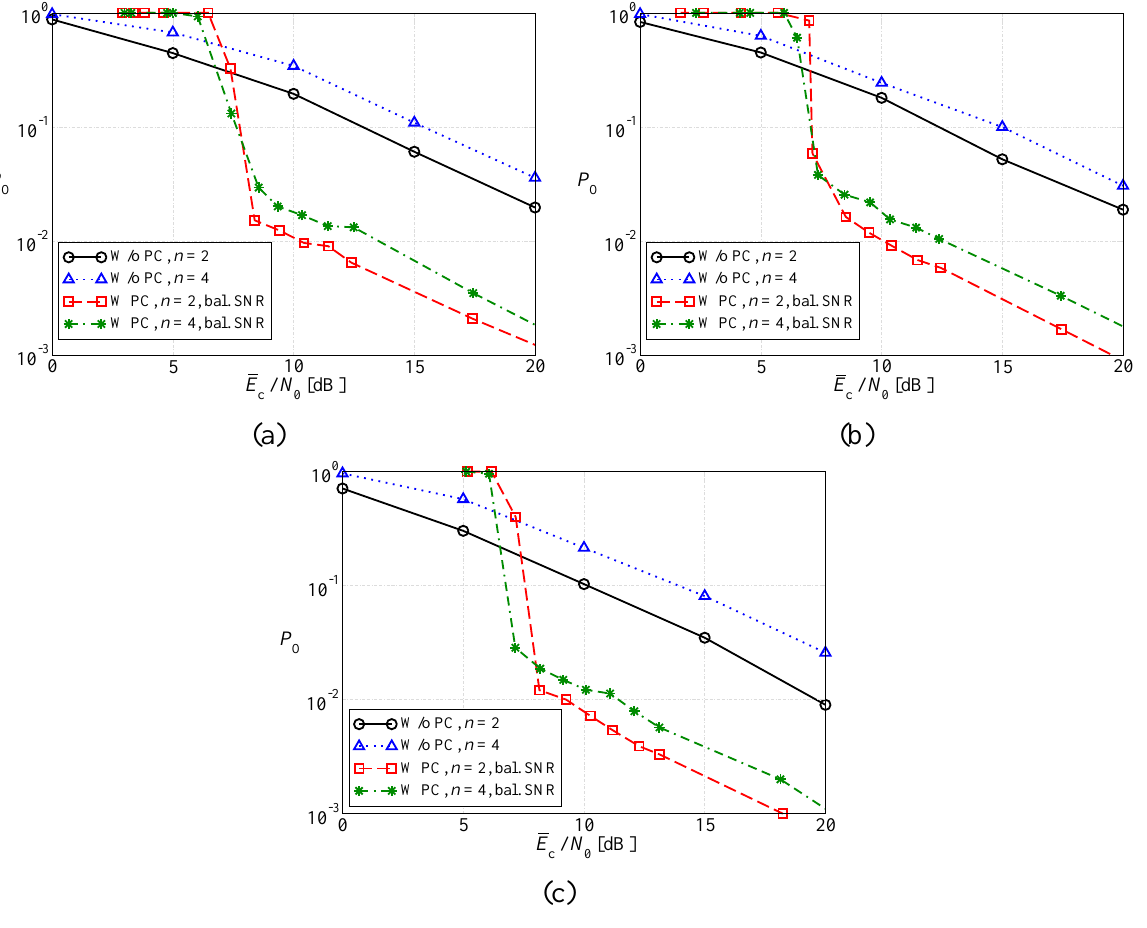
Figure 7. Outage probability, as a function of the average SNR at the sources, considering: (a) regular LDPC-coded schemes, (b) DD LDPC-coded schemes, and (c) SCCCed schemes. The performance in the presence of the balanced SNR power control strategy is compared with that associated with the absence of power